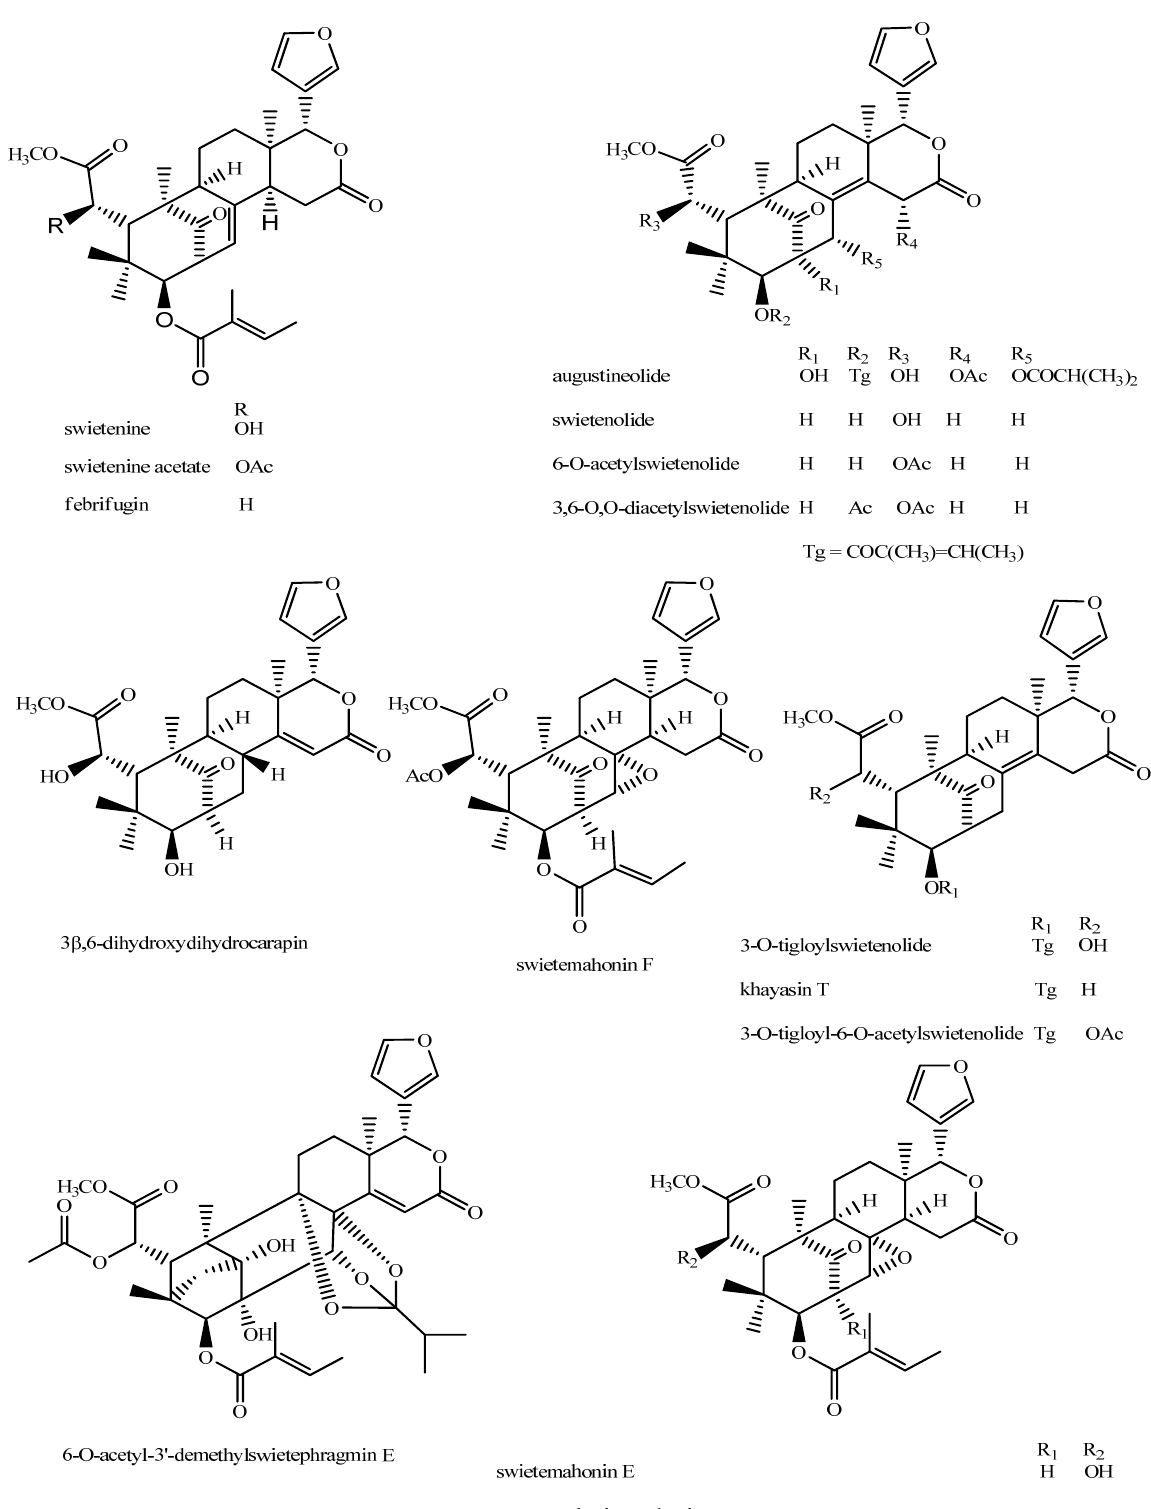
Figure 1. Chemical structures of various phytochemicals isolated from S. macrophylla